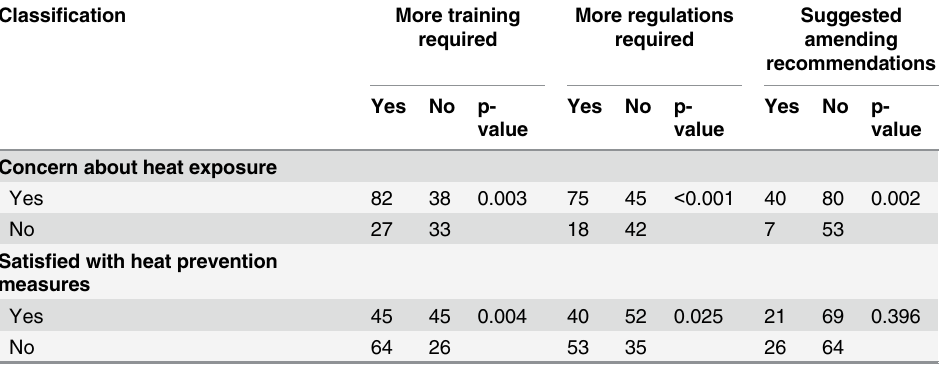
Table 5. Relationship of heat concern and satisfaction level on the attitudes towards more training and regulations, and the adjustment of heat prevention recommendations (Chi-square